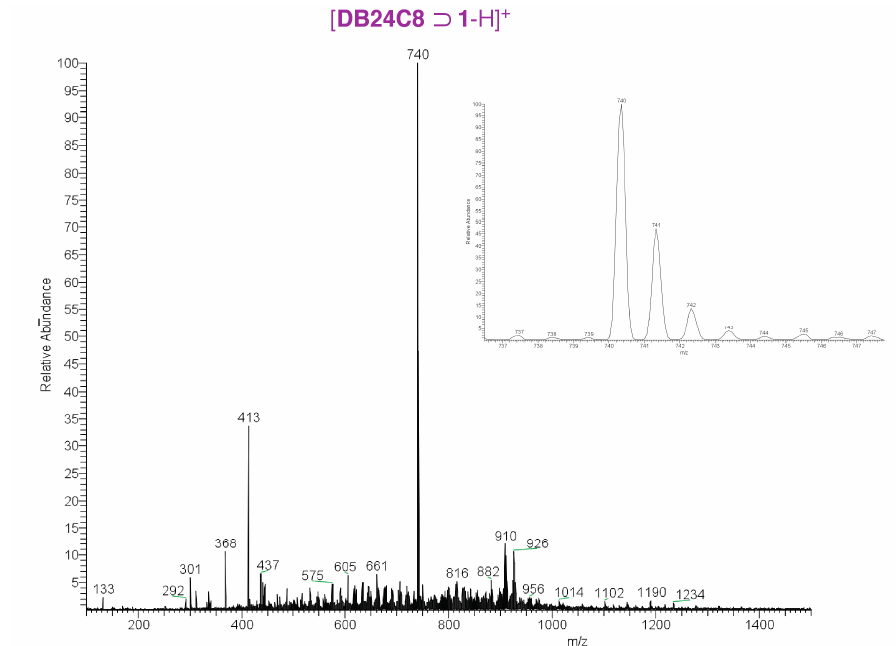
Figure 3. Electrospray ionization mass spectrometry (ESI-MS) of the [2]pseudorotaxane DB24C8 ⊃ 1 -H·PF 6 , showing the molecular ion signal [M–PF 6 ] + at m/z